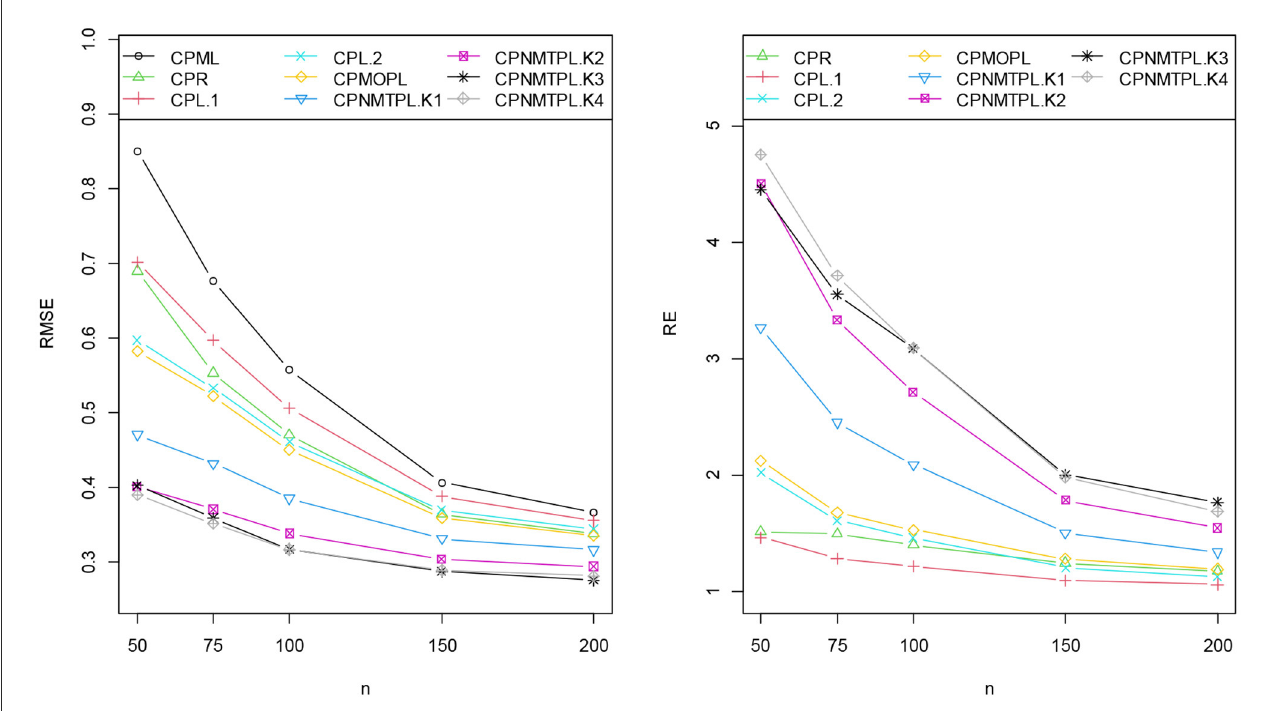
FIGURE2 RMSE and RE categorized by levels of sample size.